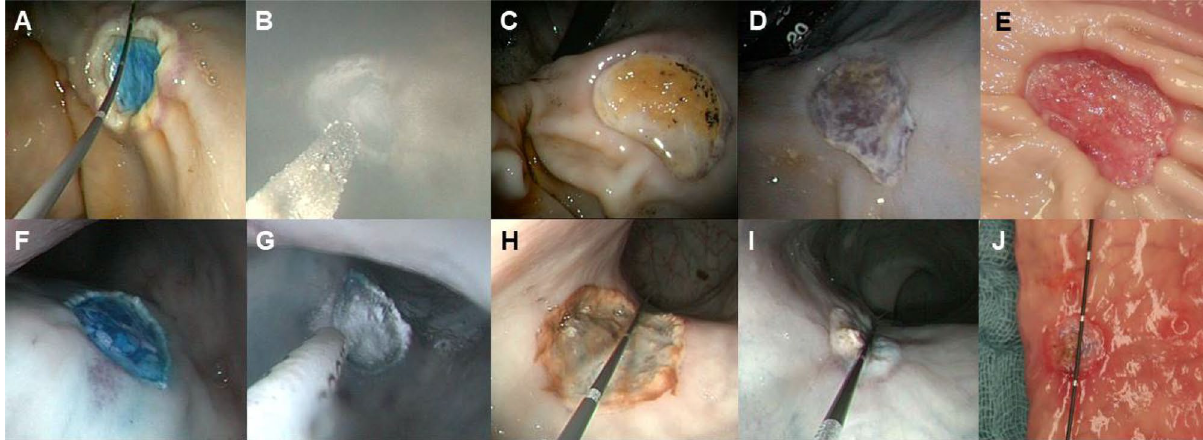
Figure 1. Workflow of the study in the porcine model (treatment group). Gastral lesions are shown in the upper line, rectal lesions in the lower line. ( A , F ) Freshly EMR-induced ulcers in the stomach and in the rectum. In ( B , G ) application of HS on both locations is presented. ( C , H ) Present the ulcers on day 2, and ( D, E, I, J ) on day 7 (end of study; ( D , I )-endoscopically; ( E, J )-ex vivo). Measurement of lesions with the centimeter- calibrated tip-wire is shown in ( A, G, H, J